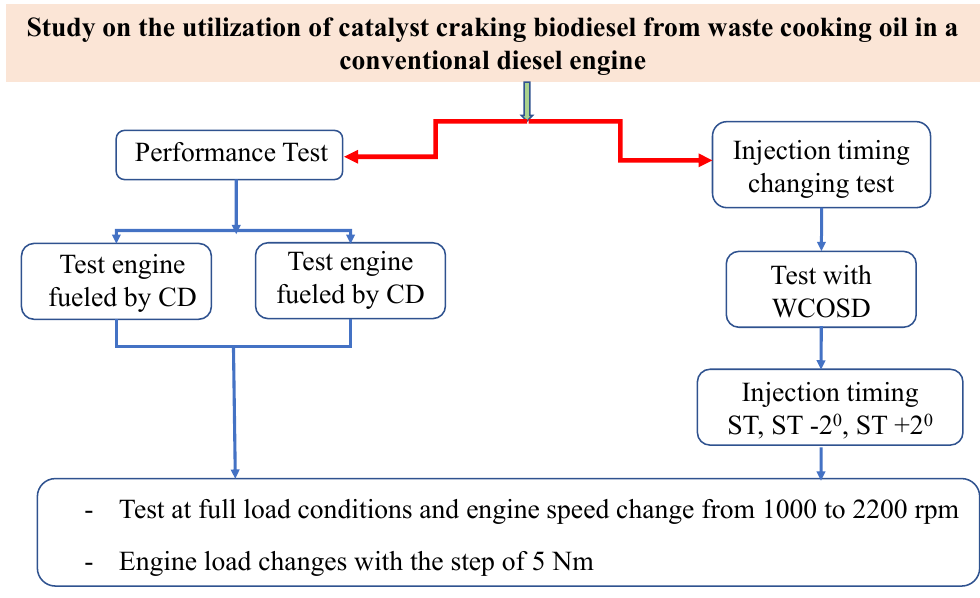
Figure 10. Experimental processes.